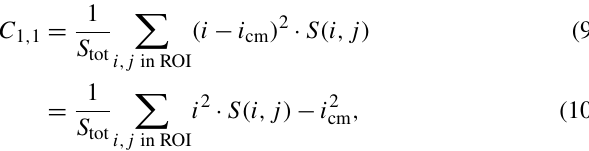
Figure 6. Example of a SO 2 CIC image from a SO 2 camera (camera 4). The image contains two SO 2 puffs marked by the detected ROI (white rectangle). Artefacts produced by a cloud are visible in the upper right